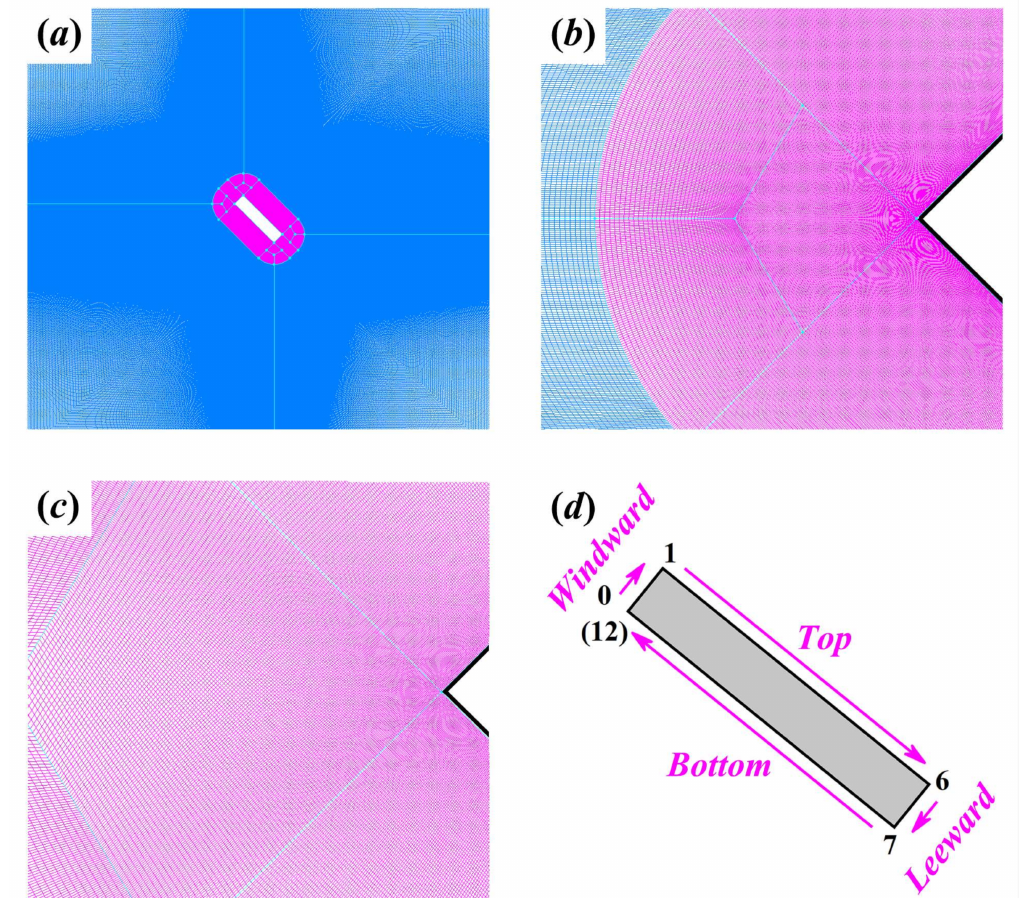
Figure 2. Grid topology and details: ( a ) mesh in the proximity of the cylinder; ( b ) close-up of the core region; ( c ) around the corner; ( d ) non-dimensional distance s/D of cylinder circumference (taking α = 45 ◦ as an